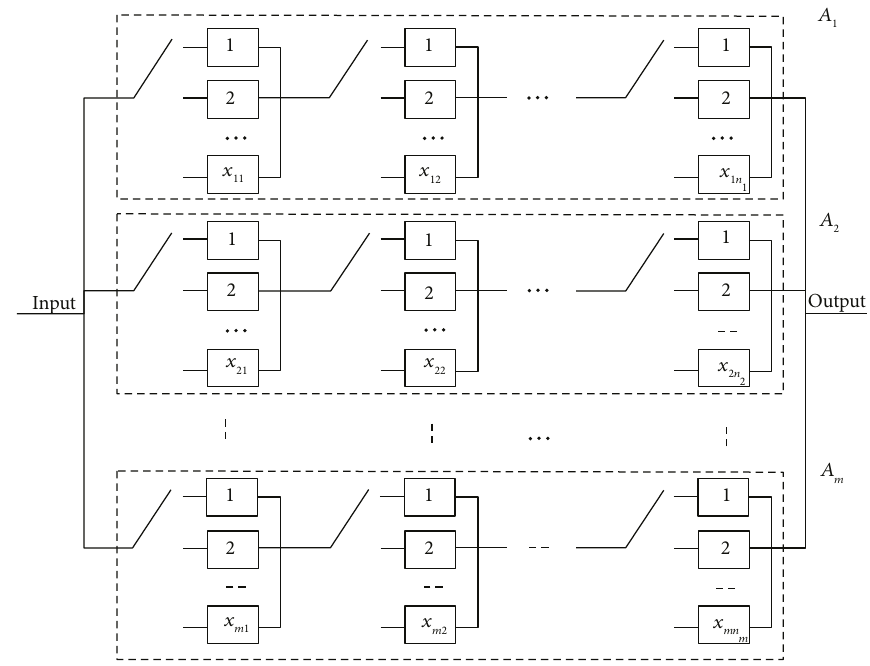
Figure 1: A warm standby redundant parallel-series